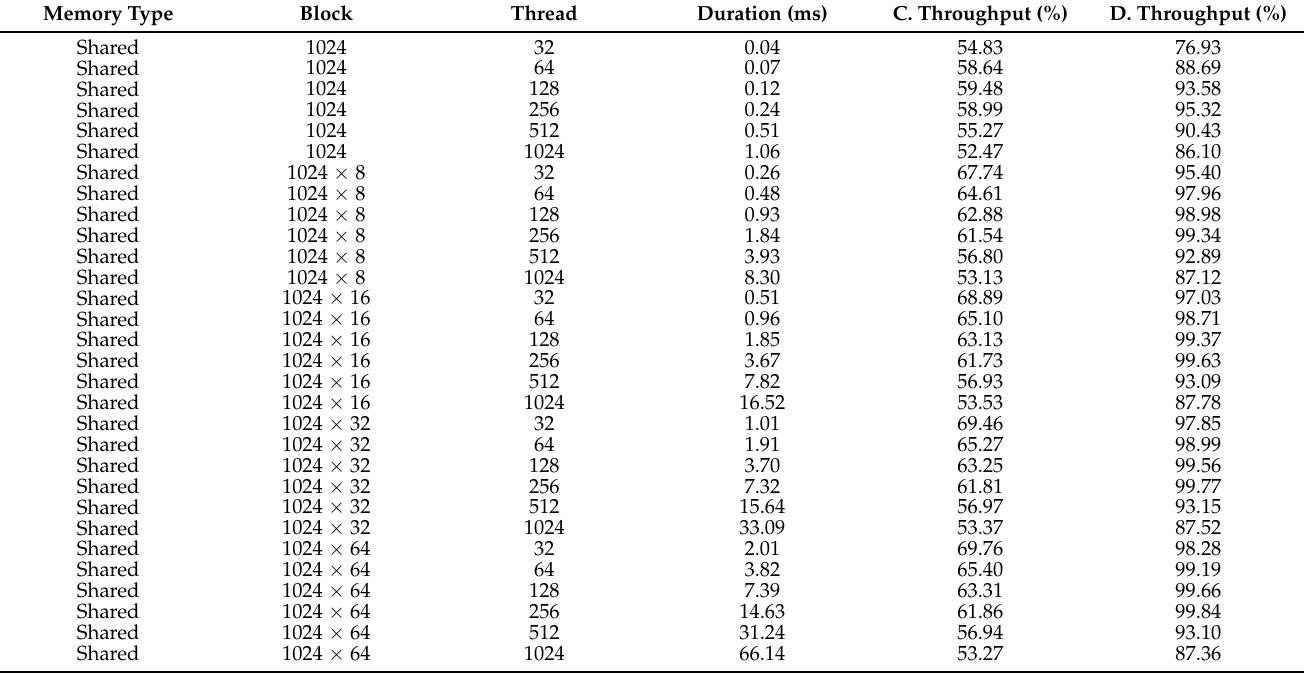
Table 8. Performance of all the shared memory implementation (C.: compute, M.: